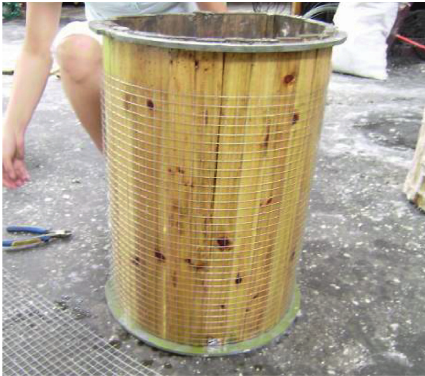
Figure 5: Double-wire mesh.